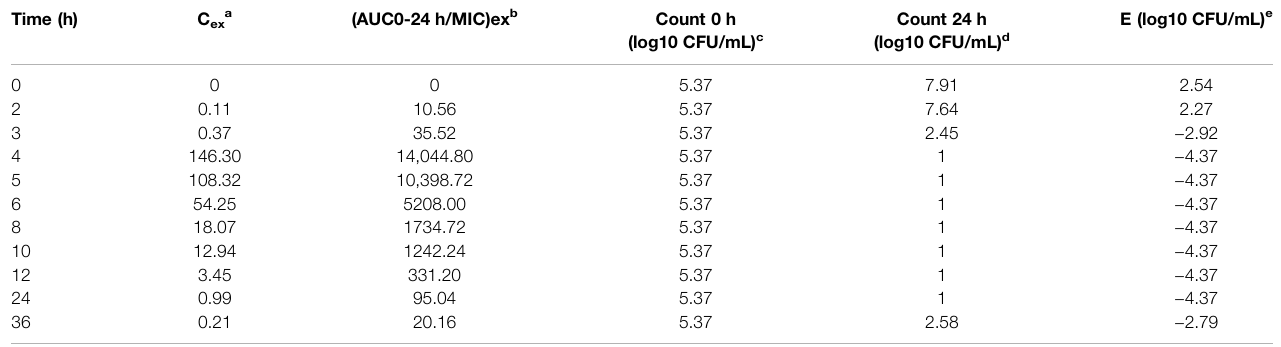
TABLE 4 | Ex vivo concentration, (AUC 0 – 24h /MIC) ex , and antibacterial effect obtained from the killing curves. Time (h)